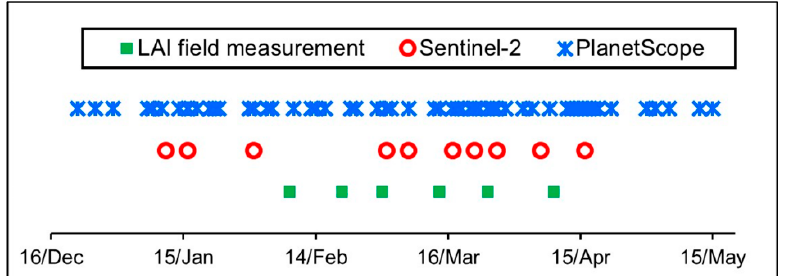
Figure 2. Wheat LAI field measurement (green), Sentinel-2 observations (red), and PlanetScope observations (blue) observation dates of Saad field from December 2017 to May 2018.